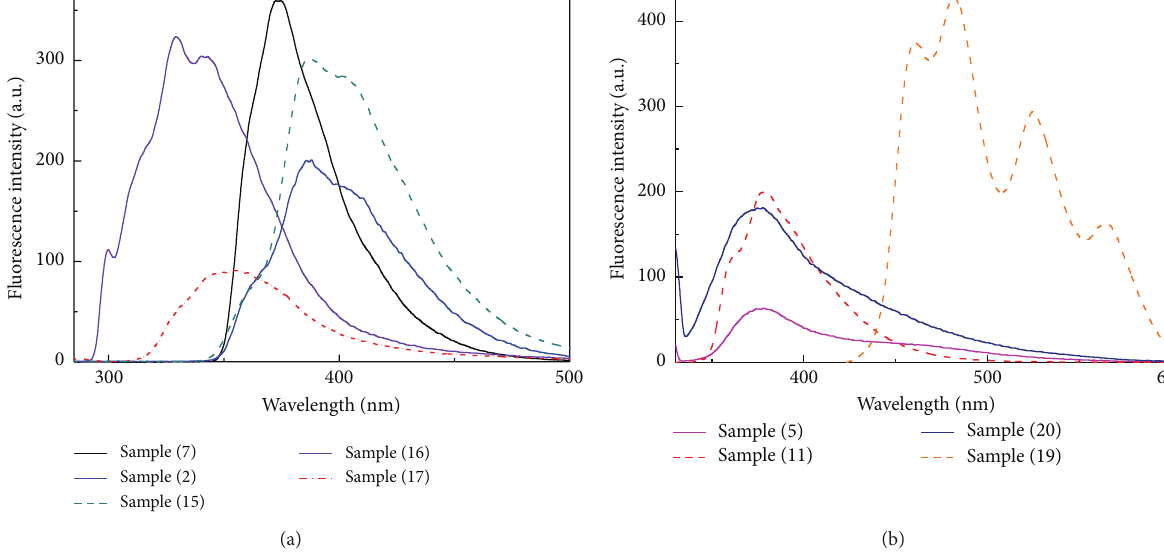
measurements of a series of fused quinazoline